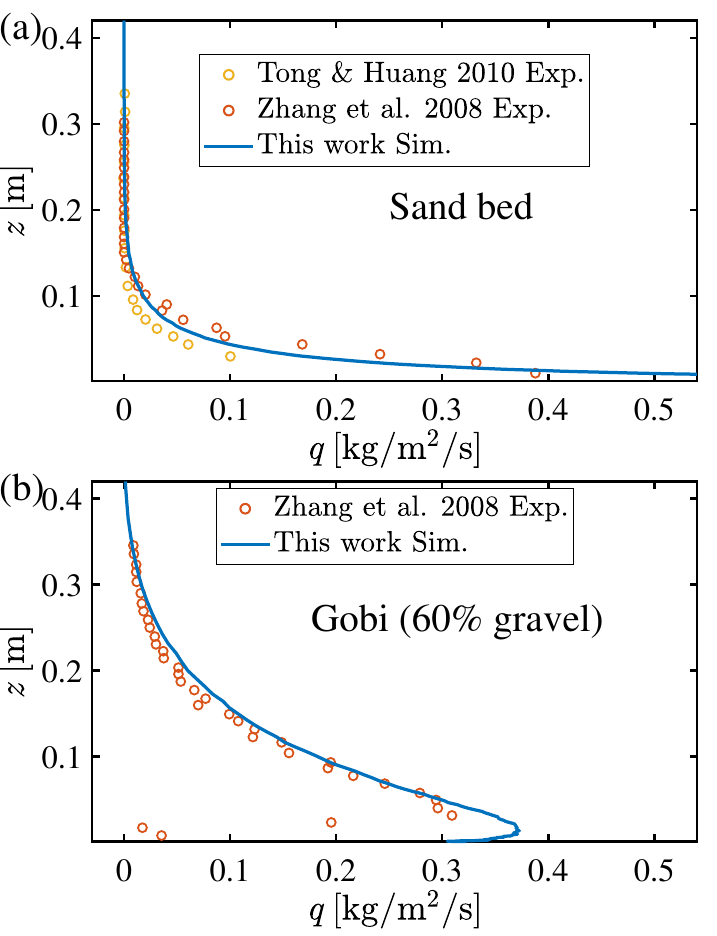
Figure 4. Comparison of the numerical results on mass flux profile with the measured data in ( a ) sand bed by Tong and Huang [29] and ( b ) Gobi with 60% gravel coverage by Zhang et al.